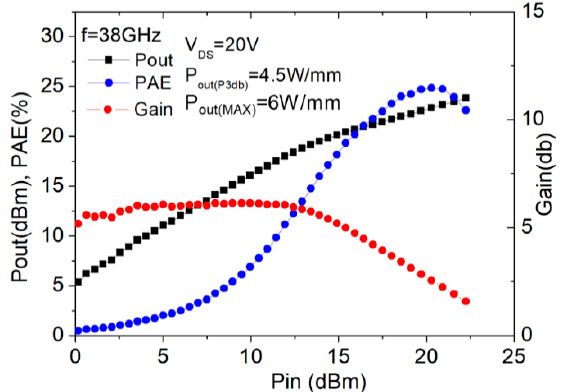
Figure 10. Large-signal performance of the 2 × 20 μ m device without copper metallization.